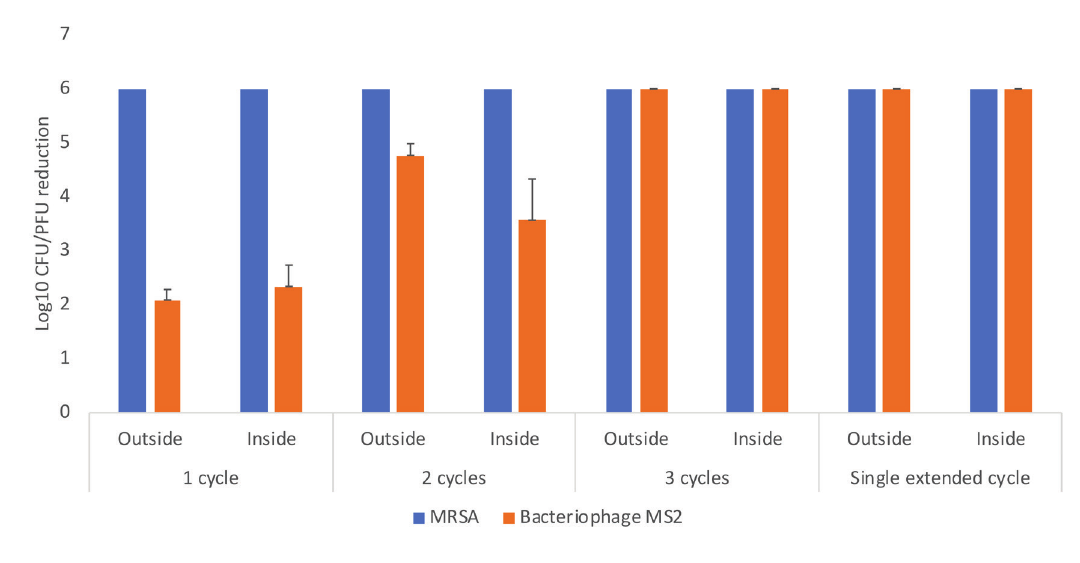
Figure 5. Efficacy of a multi-purpose high-level disinfection cabinet for decontamination or disinfection of methicillin-resistant Staphylococcus aureus (MRSA) and bacteriophage MS2 on N95 respirators. 10-μL aliquots containing 10 6 colony-forming units (CFU) or plaque-forming units (PFU) of the test organisms in the simulated mucous suspension were spread to cover an area of 1-cm 2 on 3 different areas on the respirator surface (top exterior, edge exterior, and interior) as shown in Figure 1. The respirator was ex- posed to 1, 2, or 3 22-minute treatment cycles or a single extended cycle of 31 minutes. Error bars indicate standard